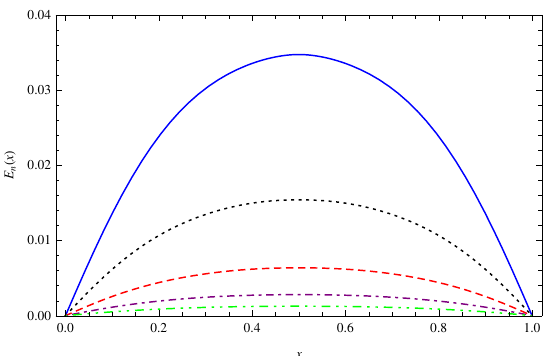
Figure 2: Curves of the error functions E n ( x ) for n = 4 (solid line), n = 5 (dot line), n = 6 (dashed line), n = 7 (dot-side line), and n = 8 (dot-dot-side line).